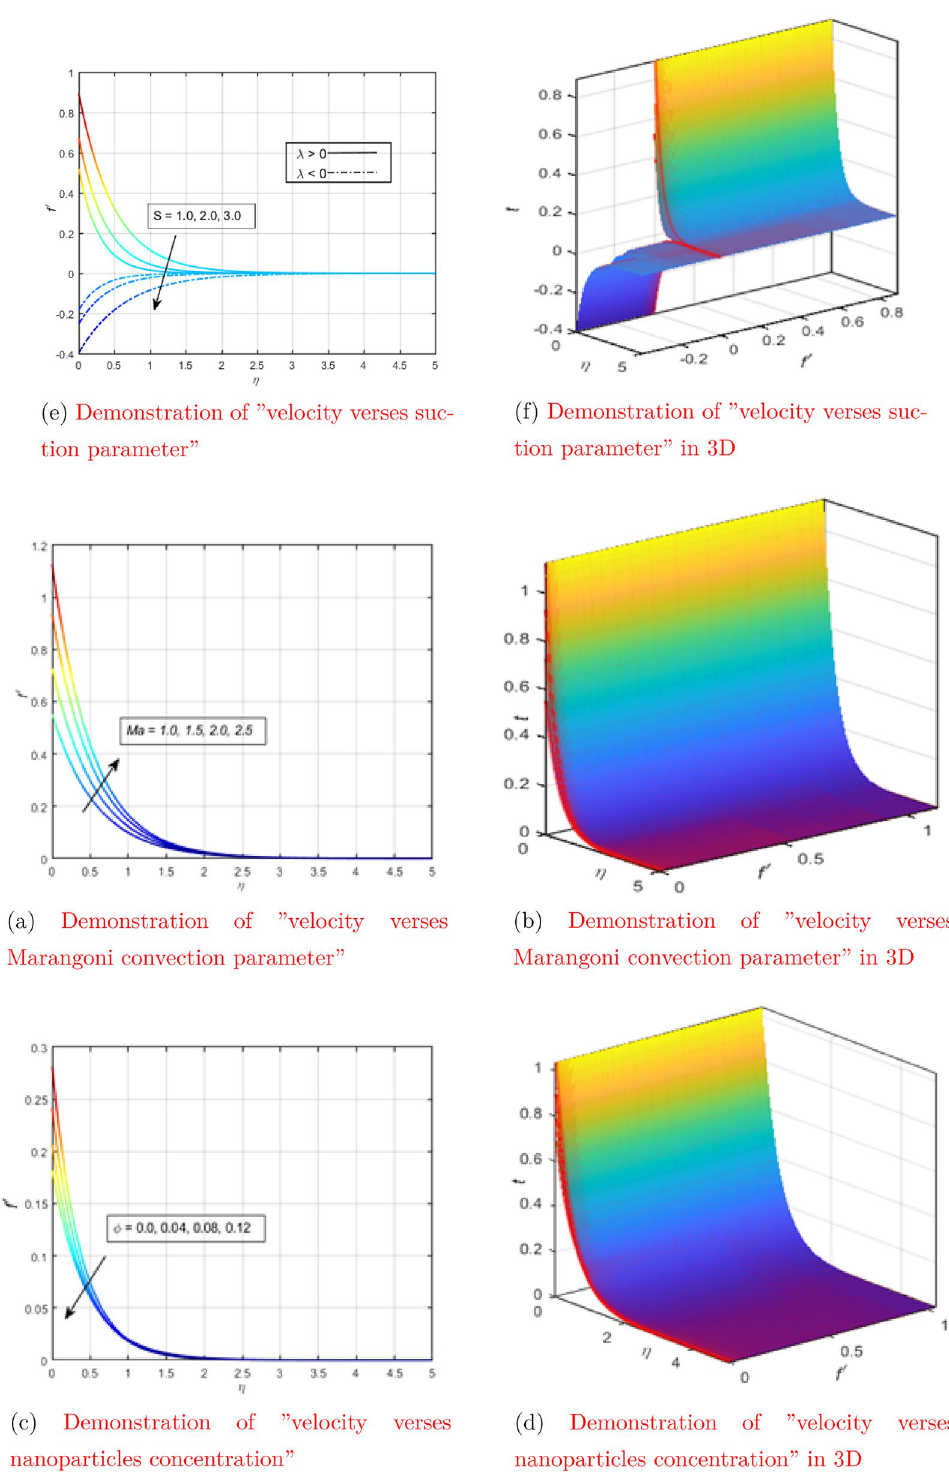
Figure 3. Demonstration of the dependence of velocity on the physical parameters in both 2D and 3D (see Appendix